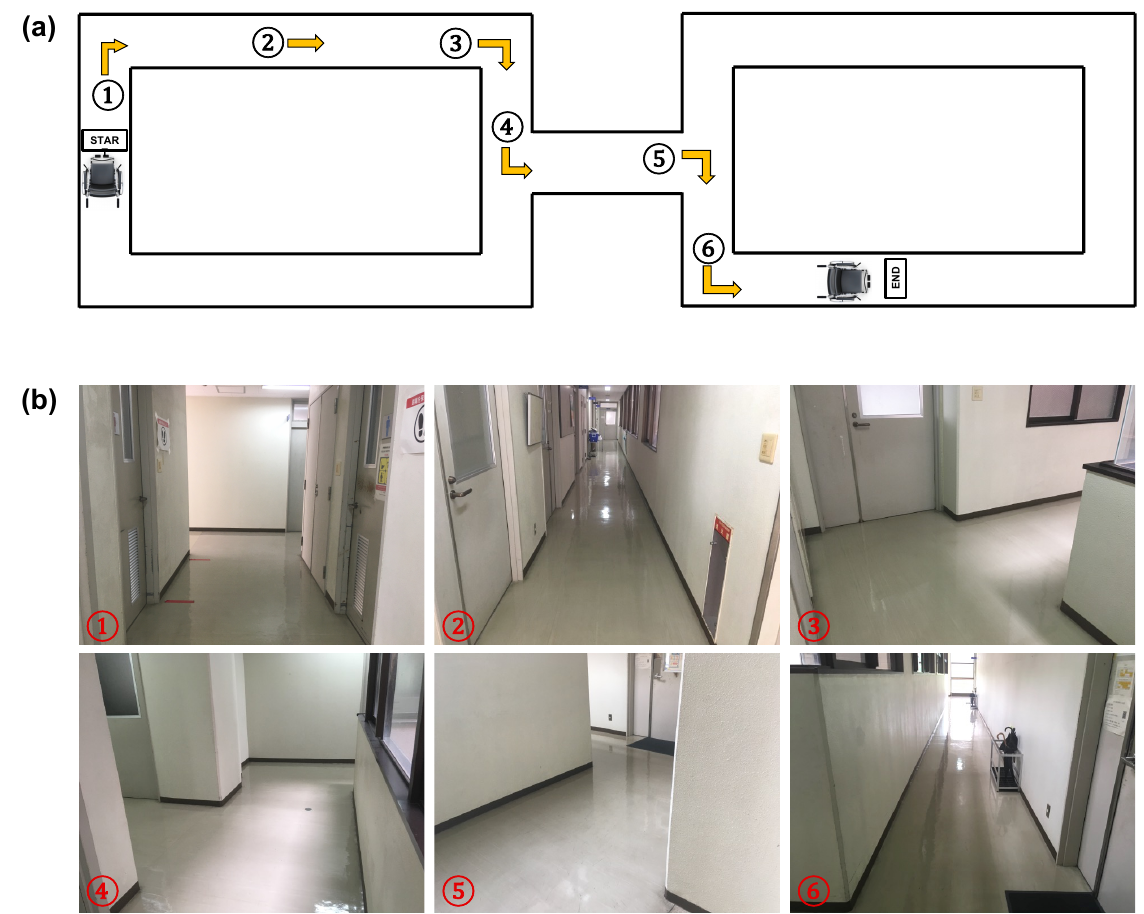
Figure 11. Route map of the experiment: ( a ) Overhead view of the route map of the experiment; ( b ) Actual view of the driving route. The numbers in the diagram indicate the actions to be taken by the subjects. For number 1 in the diagram, the subjects go straight and then turn right at the end of the street. For number 2, the subjects go straight ahead. When they pass a poster on the wall, they have to read it. For number 3, the subjects turn right at the corner. For number 4, the subjects go straight and then turn left at the first corner. For number 5, the subjects go straight and then turn right at the end of the street. For number 6, the subjects turn left at the corner and go straight to the finish line. Note: Each figure in the actual view of the driving route ( b ) corresponds to the number shown in the overhead view ( a